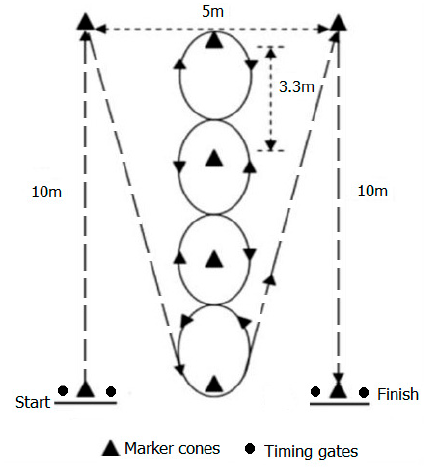
Figure 1. Schematic of the Illinois agility test.